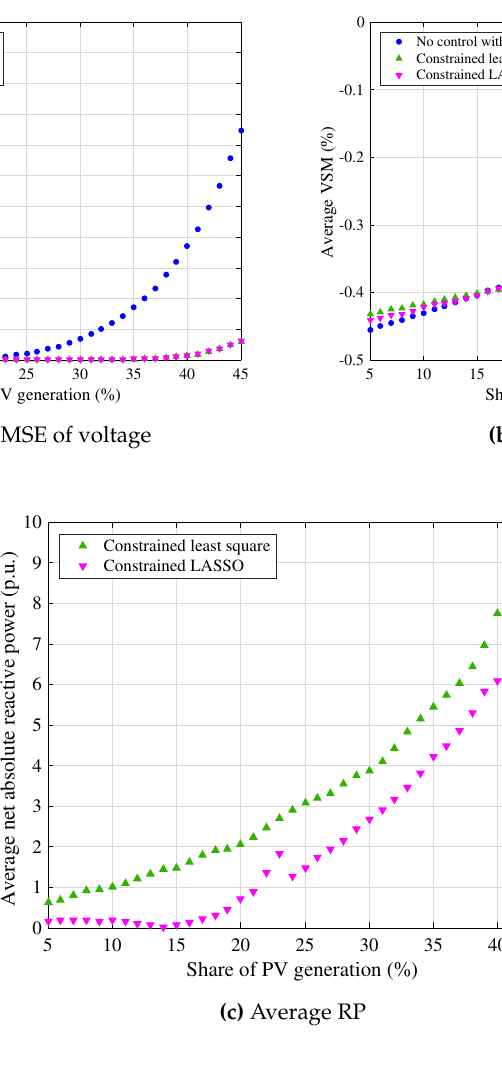
Figure 4. Uniform distribution of PV generators at consumer buses of the 39-bus power system. Real power generation from one PV: 0.2p.u.; Fixed net real power generation by PV, in terms of its share ratio to net consumer demands, snap results of share ratio ranges from 5% to 45%; MSE of voltage: Mean square error of voltage from the reference voltage; VSM: Voltage stability margin which evaluates the voltage stability and system capability of PV integration at the current system operating point; RP: Net absolute reactive power generation from PV